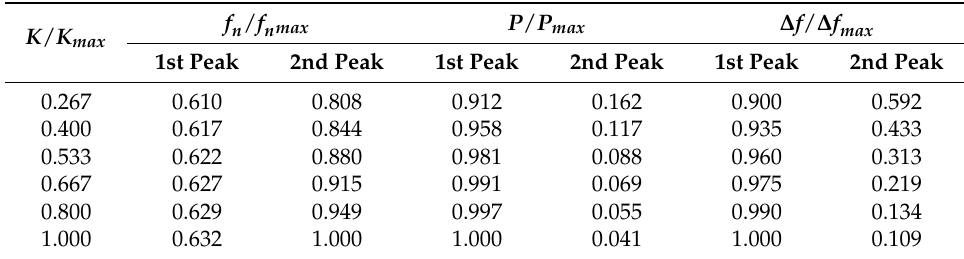
Table A2. Two bimorphs connected by a spring system—the influence of the normalized spring constant on the normalized harvested power. K / K